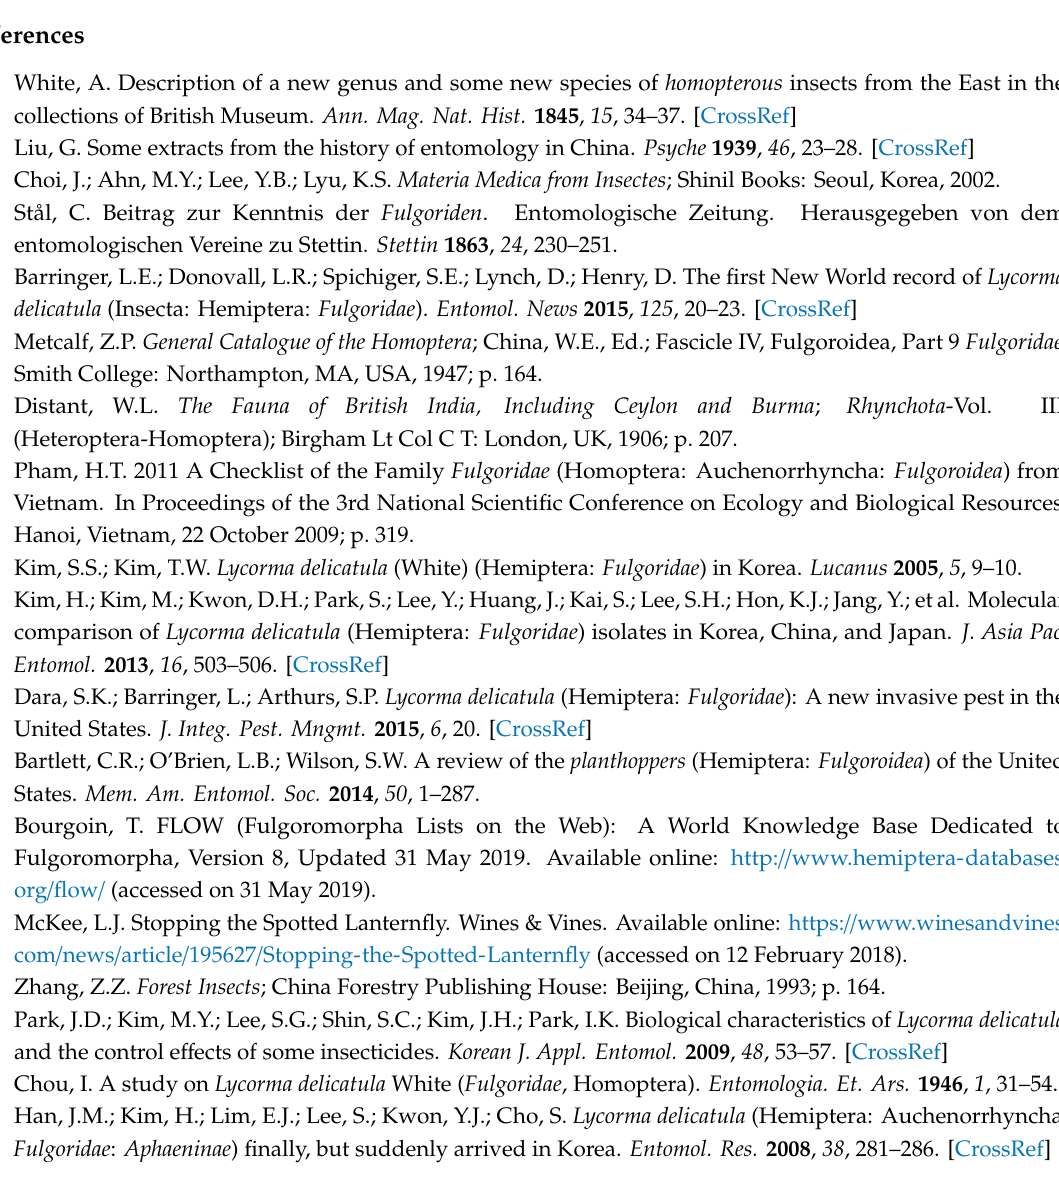
south of Yangtze River). Table S4: The population size and numbers of e ff ective immigrants per generation between four clusters inferred from STRUCTURE analysis based on the microsatellite and the combined mitochondrial datasets. Table S5: The population size and numbers of e ff ective immigrants per generation between two clusters (the cluster north of the Yangtze River and the cluster south of Yangtze River) based on the microsatellite and the combined mitochondrial datasets. Table S6: The Wilcoxon test under TPM and SMM models based on the microsatellite datasets and Tajima’s D and Fu’s Fs tests based on the combined mitochondrial dataset. Figure S1: Estimated number of genetic clusters obtained with STRUCTURE analysis for K ranging from one to eight using 13 microsatellite markers for eight populations. Figure S2: Results of principle coordinate analysis based on 13 microsatellite markers in eight Lycorma delicatula populations in China. Figure S3: Scatter plots of the genetic distance isolation by geographical distance among Lycorma delicatula populations in China based on 13 microsatellite markers and two mitochondrial